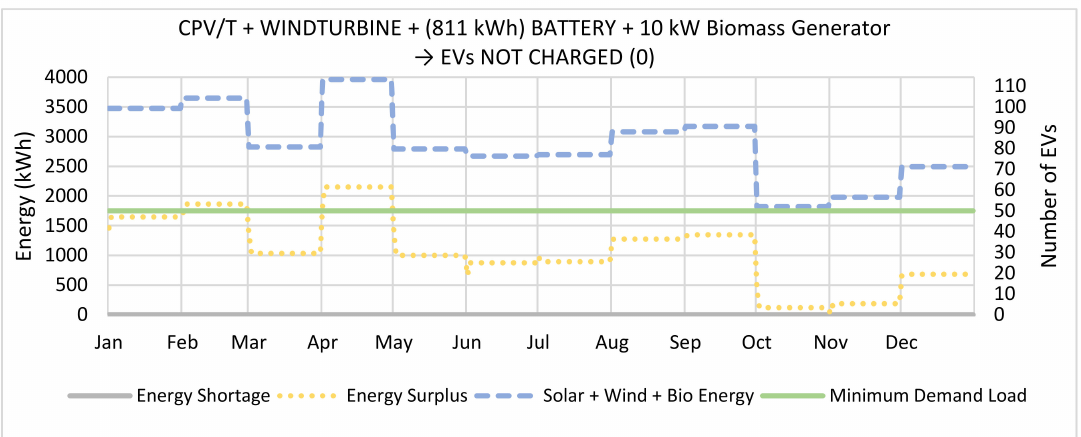
Figure 13. CPV / T, WT, biofuel power generator and BSS annual simulation